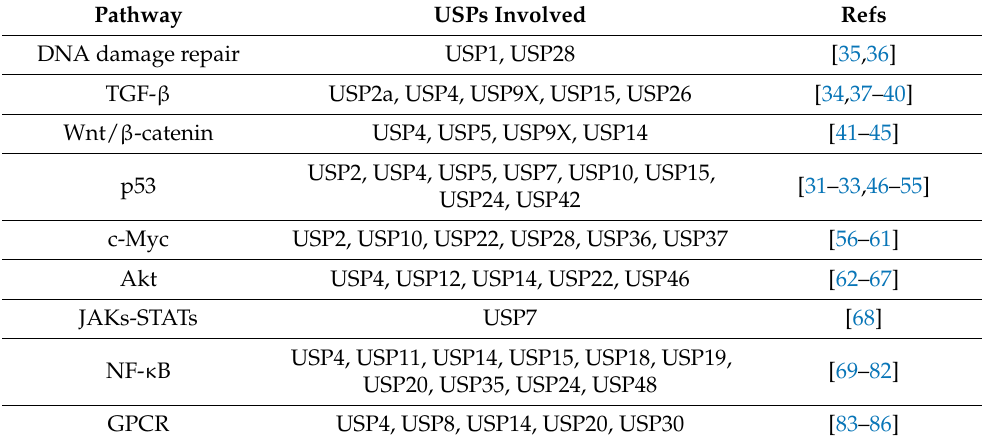
Table 1. Cancer-related pathways regulated by USPs.